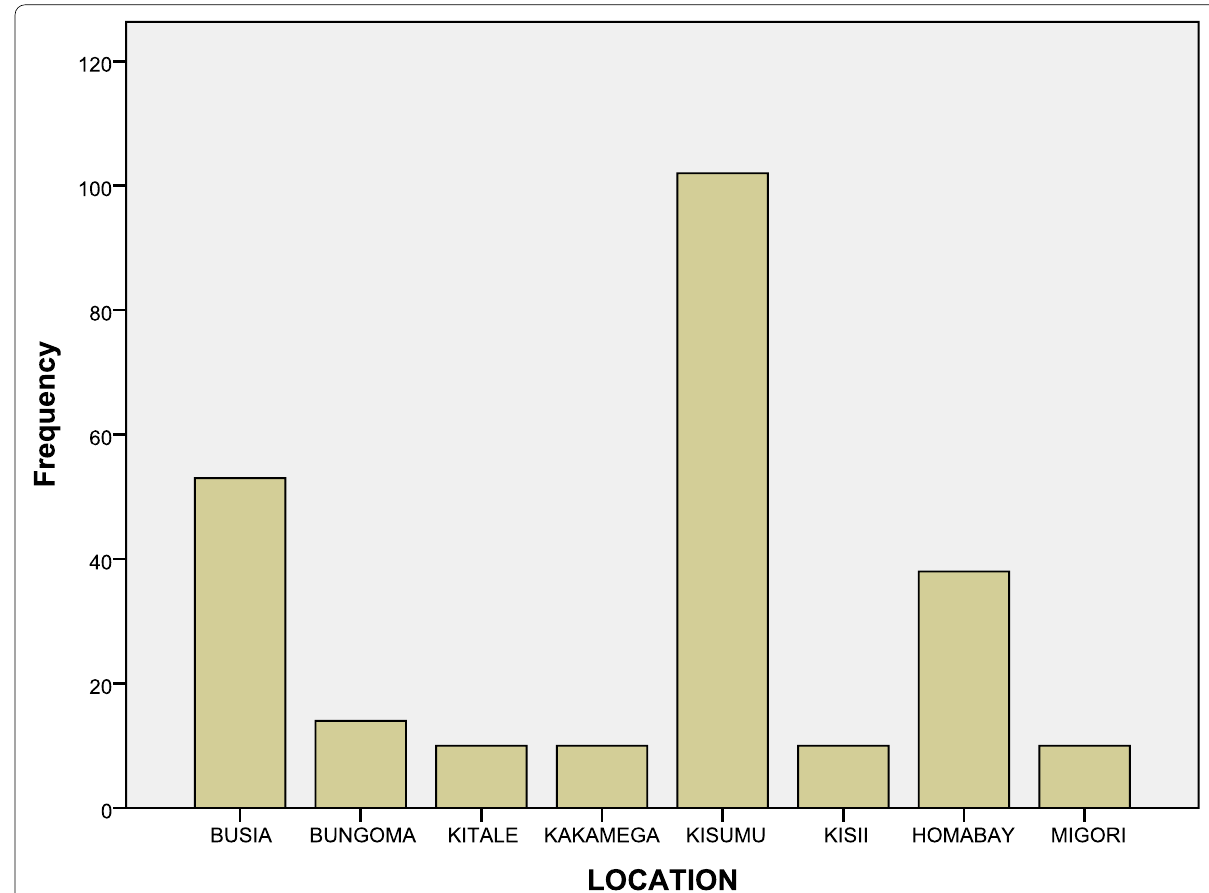
Fig. 2 Distribution of hemoglobinopathies among patients investigated at Aga Khan Hospital, Kisumu, and its satellite centers in Western